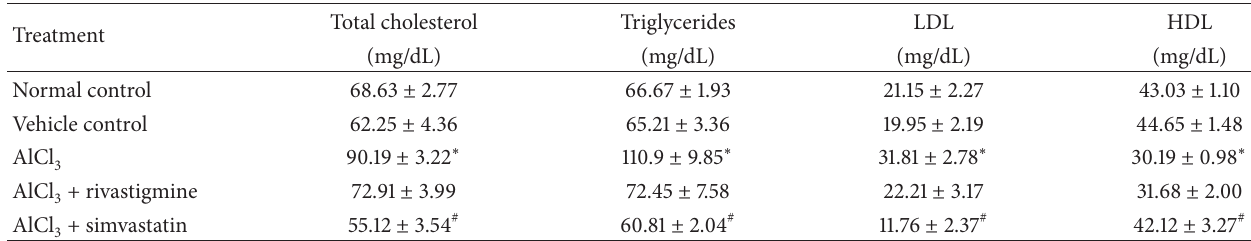
Table 1: Effect of simvastatin on serum lipid